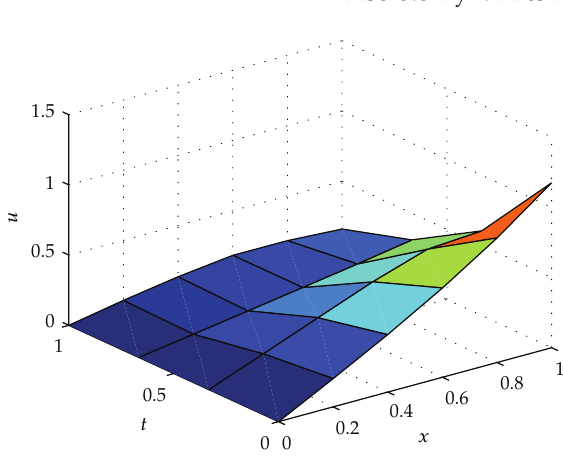
Figure 2: Numerical solution. Table 1: RMS errors of scheme (cid:3) 2.5 (cid:4) and the scheme in (cid:6) 29 (cid:7) for α (cid:9) 10, β (cid:9) 0 when λ (cid:9) 3 .